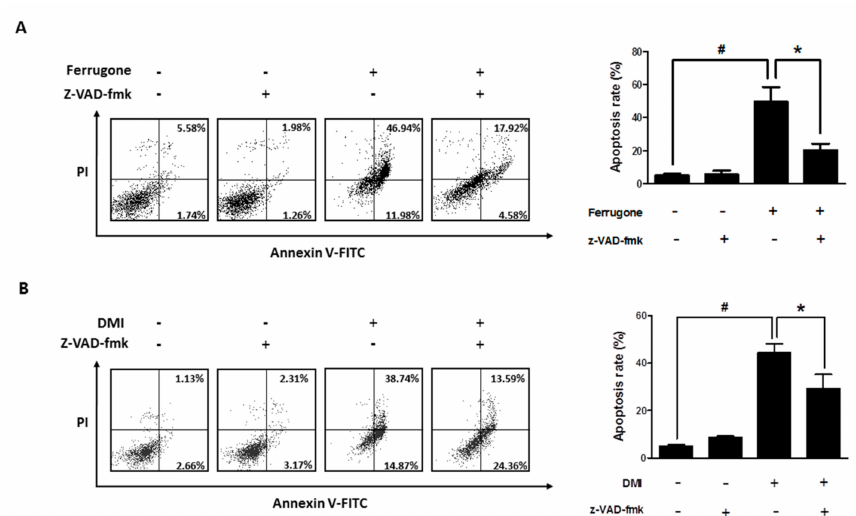
Figure 3. Involvement of caspases in ferrugone and DMI-induced cell death in human ovarian cancer cells. A2780 cells were pretreated with broad caspase inhibitor z-VAD-fmk (50 µ M) for 2 h, and then treated with ferrugone ( A ) and DMI ( B ) (0.5 µ M) for 48 h. Annexin / PI V-FITC staining assay was performed to determine apoptosis. The graph indicates the percentages of annexin V-positive apoptotic cells in the right quadrants of flow cytometry graphs. The data are representative of three independent experiments. Student’s t -test (two-tailed) was applied to evaluate the significance. # p < 0.05 as compared with the untreated group. * p < 0.05 as compared with the ferrugone or DMI only-treated group.